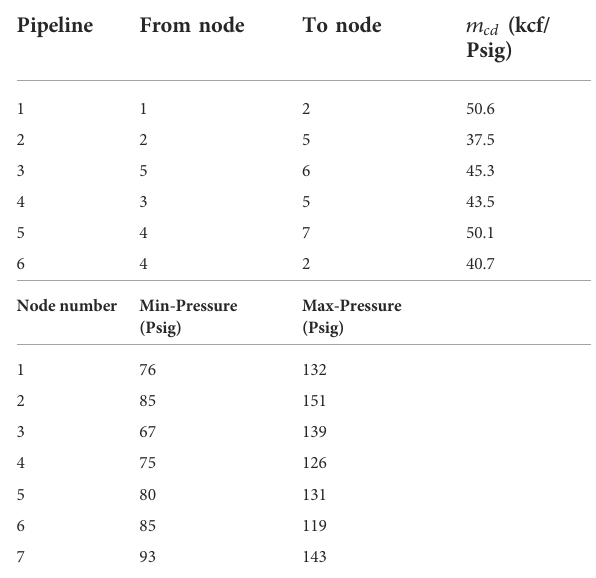
TABLE 6 Parameters of the gas network.